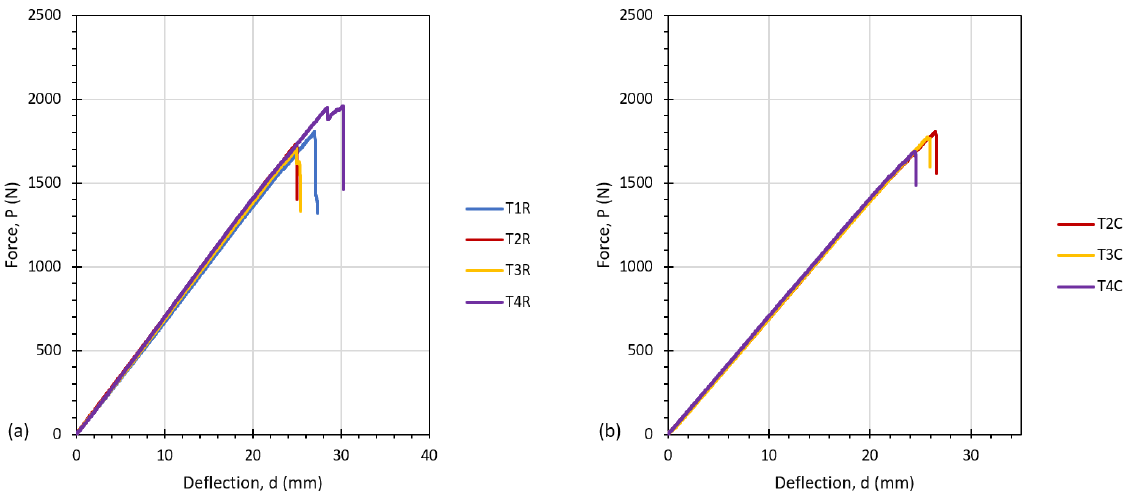
Figure 7. ( a ) Uncoated rebars, force vs. deflection. ( b ) Coated rebars, force vs. deflection. Table 4. Flexural test experimental